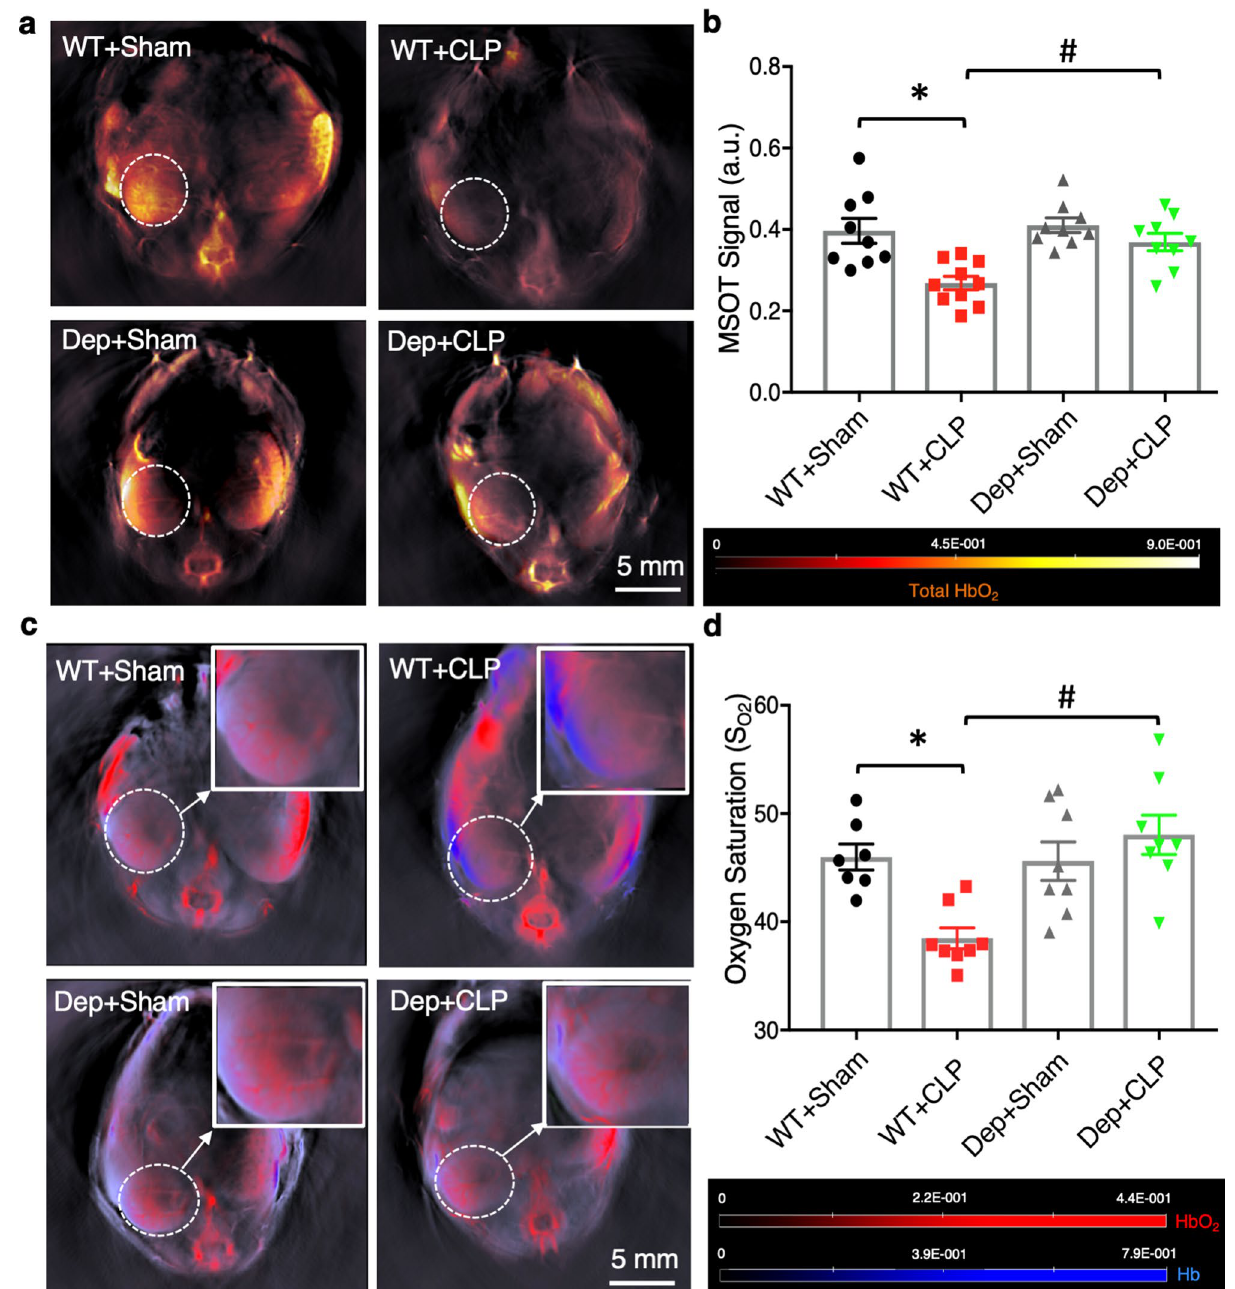
Figure 4. DHHC21 functional deficiency prevents the reduction of renal perfusion and renal oxygen saturation after septic injury. ( a ) Representative MSOT images showing the intensity of total hemoglobin in kidneys. MSOT images are pseudo-colored with hot-color scale. ( b ) Higher signal intensity of total hemoglobin is observed in kidneys of Zdhhc21 dep/dep mice than WT ones after septic injury. n = 9. ( c ) Reconstructed MSOT images indicate the distribution of oxygenated hemoglobin (red) and deoxygenated hemoglobin (blue) in kidney cross sections 24 h after CLP induction. ( d ) Zdhhc21 dep/dep mice display higher level of renal S O2 compared to WT mice after septic injury. ROIs are drawn around right kidneys. n = 8. Results represent mean ± SEM. *p ≤ 0.05 versus WT + Sham, # p ≤ 0.05 versus WT +